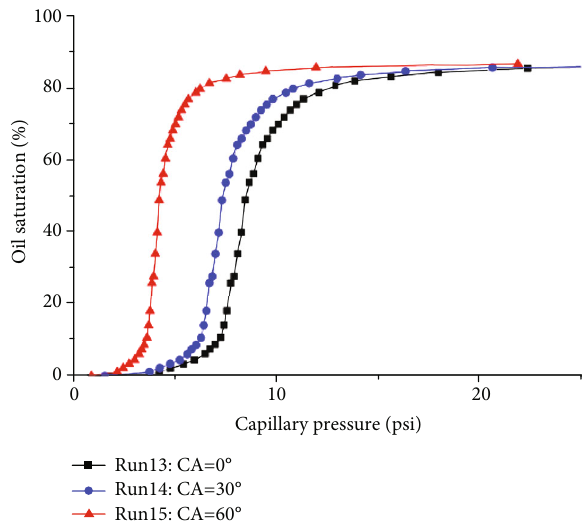
Figure 14: E ff ect of wettability conditions on oil charging